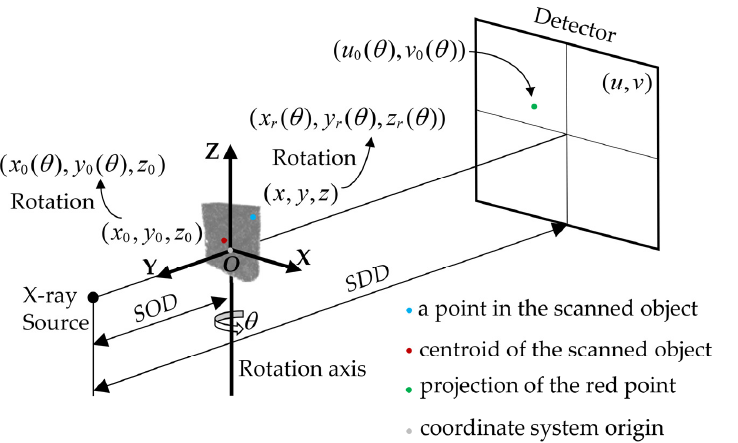
Figure 2. A simple geometric model of nano-CT. Here, SDD is the source-to-detector distance. SOD is the distance from the X-ray source to the rotation axis. θ is the rotation angle. A coordinate system is established with the intersection of the line connecting the X-ray source emission point to the detector center and the rotation axis as the origin O (grey point). ( x , y , z ) is the coordinate of a point (blur point) in the scanned object when the object is not rotated. ( x r ( θ ) , y r ( θ ) , z r ( θ )) is the rotation coordinate of ( x , y , z ) at the rotation angle θ . ( x 0 , y 0 , z 0 ) is the centroid of the scanned object (red point), and ( x 0 ( θ ) , y 0 ( θ ) , z 0 ) is the rotation coordinate of ( x 0 , y 0 , z 0 ) . u and v are the horizontal and vertical coordinates of the projection, respectively, and ( u 0 ( θ ) , v 0 ( θ )) is the projection position (green point) of ( x 0 ( θ ) , y 0 ( θ ) , z 0 ) The object was scanned via X-ray and projection was formed on the detector. The θ should satisfy the following: projection position of the ( ( ), ( ), ( )) r